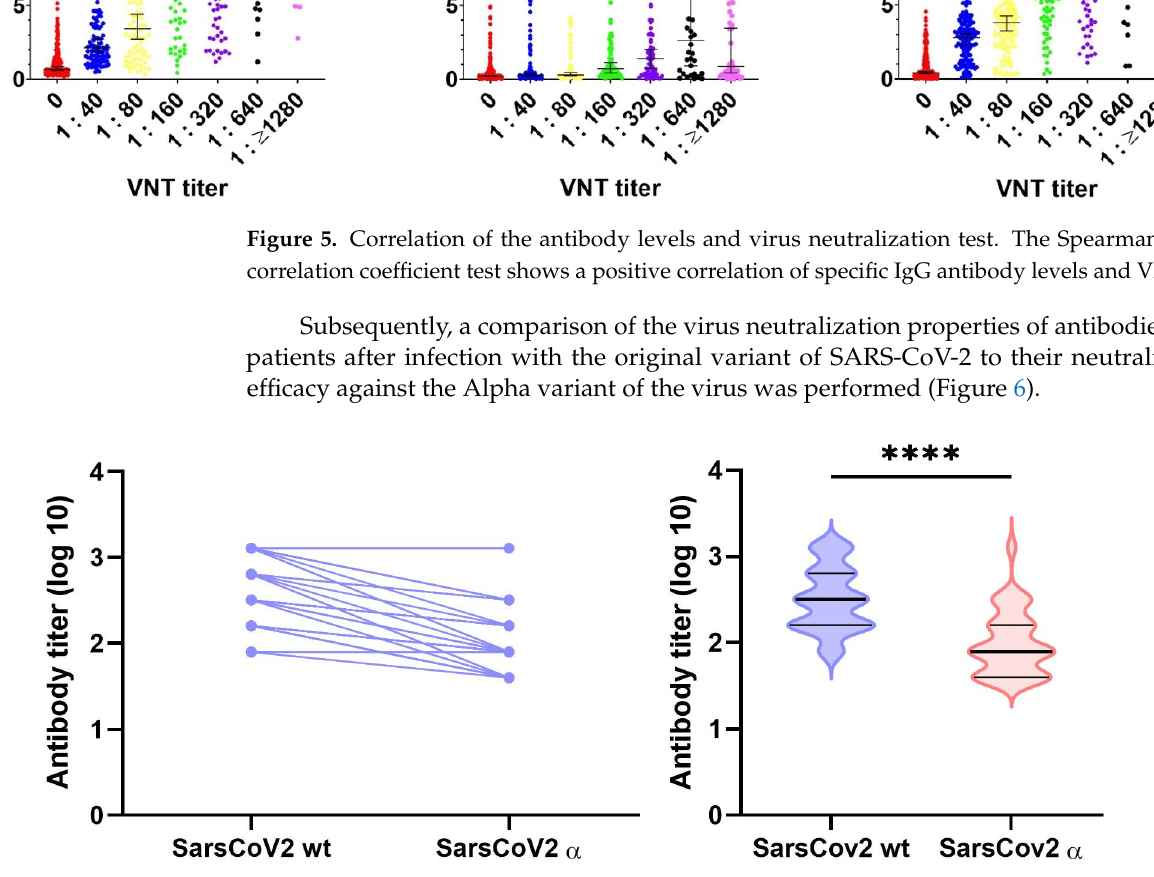
Figure 6. Neutralization of the SARS-CoV-2 Alpha variant with serum samples from patients infected with the original virus variant. The left panel shows a correlation of the virus neutralization titers against the original variant and the Alpha variant by the individual sera. The right panel shows the cumulative values of this analysis. In both panels, decreases in the VNT levels against the Alpha variant are observed. The nonparametric Mann–Whitney test was used for the analysis and **** represents the significance at p < 0.0001.